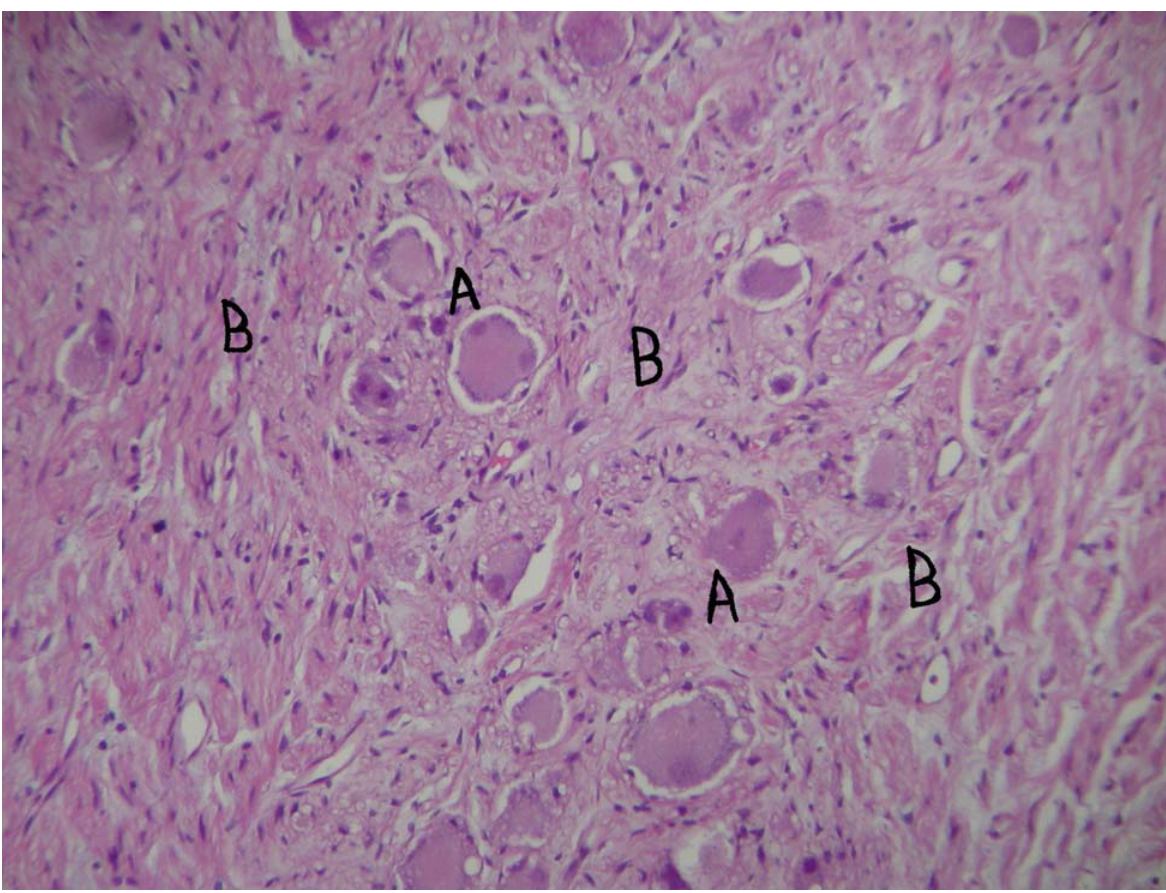
FIGURE 2 . Irregular distribution of histologically mature ganglion cells (A) in a background of spindle cell matrix representing Schwann cells (B). H & E, reduced from ×